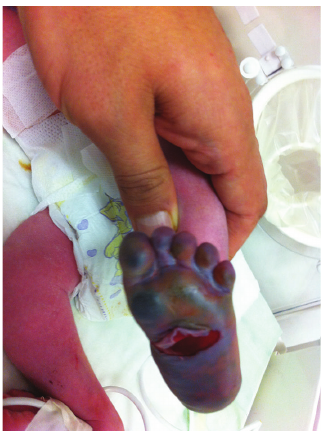
Figure 1: Hemorrhagic skin reaction and skin necrosis throughout his left